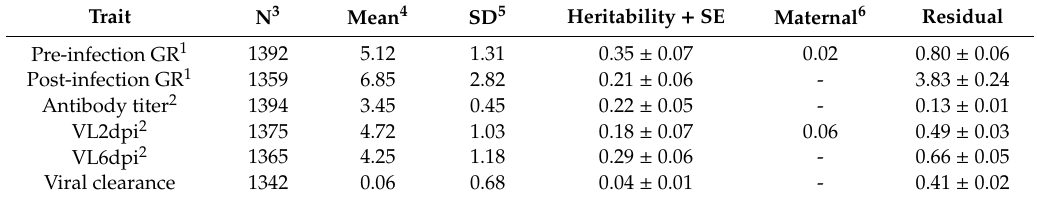
Table 2. Trait statistics and estimates ( ± SE) of variance components from univariate analyses.